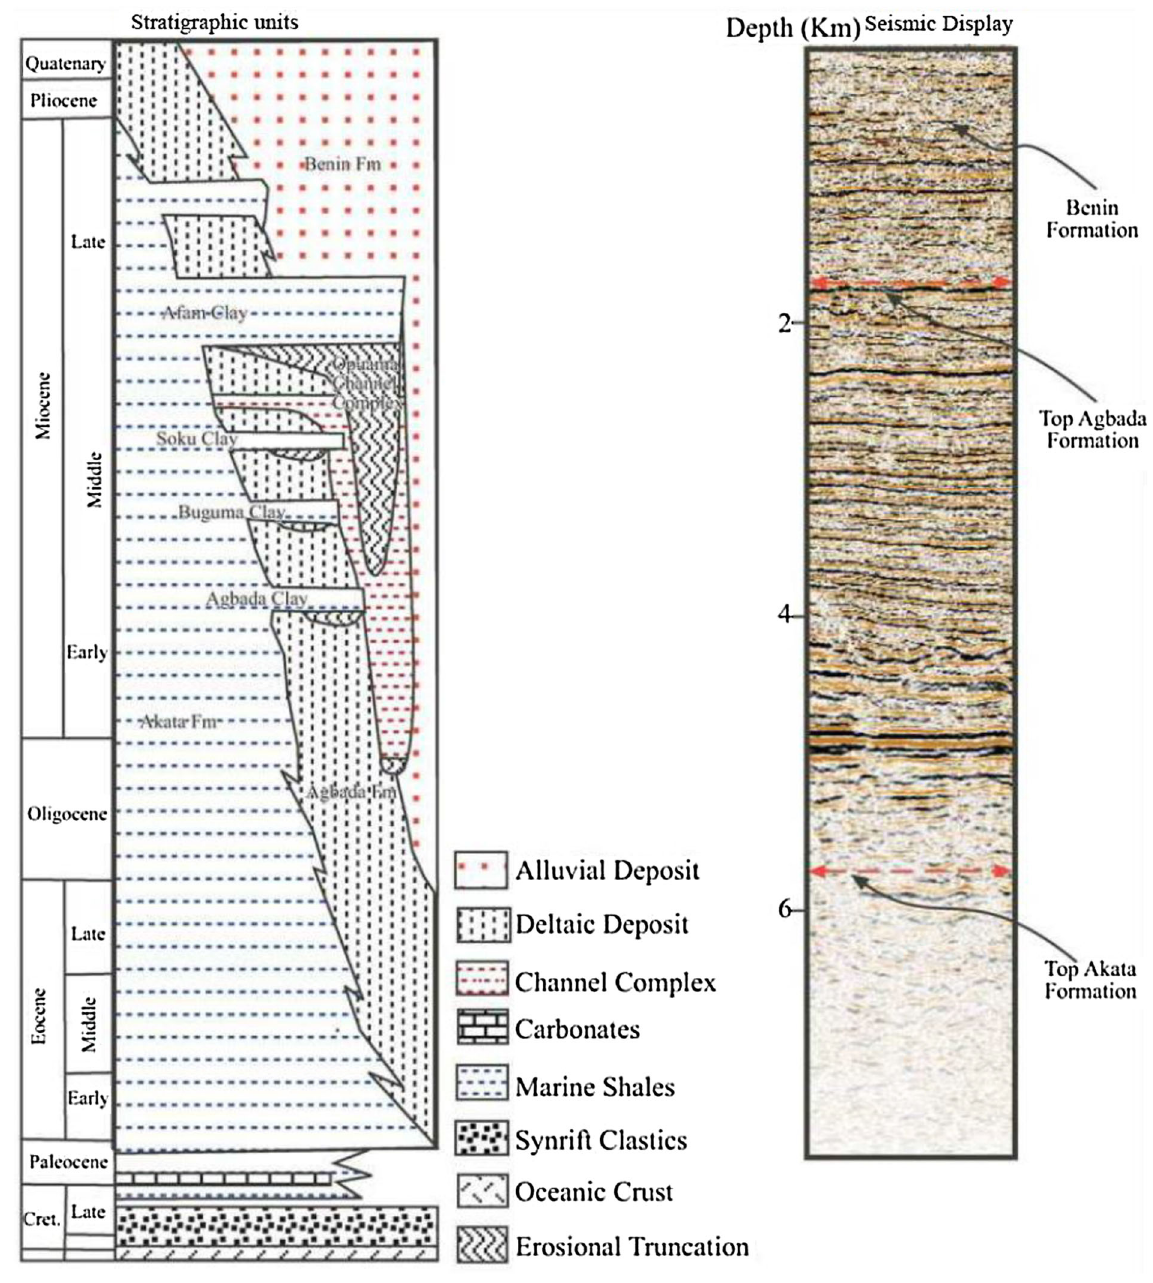
Fig. 2 Stratigraphy of the Niger Delta and variable density seismic display of the main stratigraphic units in the outer and thrust belt and the main reflectors (Lawrence et al.